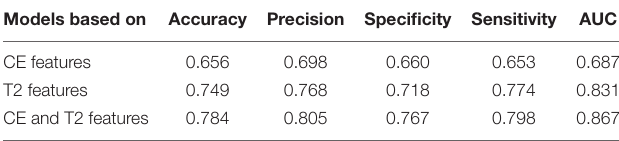
TABLE 3 | The predicting performance of the groups of models in the validation